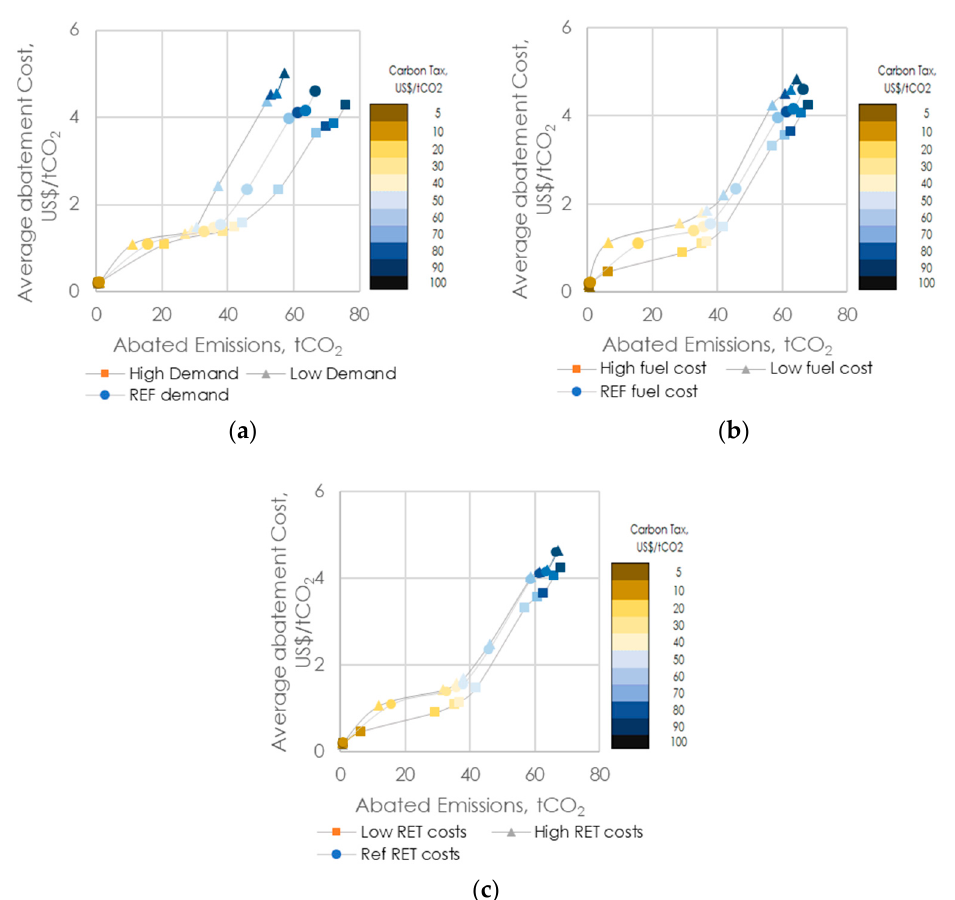
Figure 12. Parameter sensitivity-analysis results. ( a ) Electricity demand, ( b ) fuel production costs and ( c ) renewable energy technology (RET) costs.